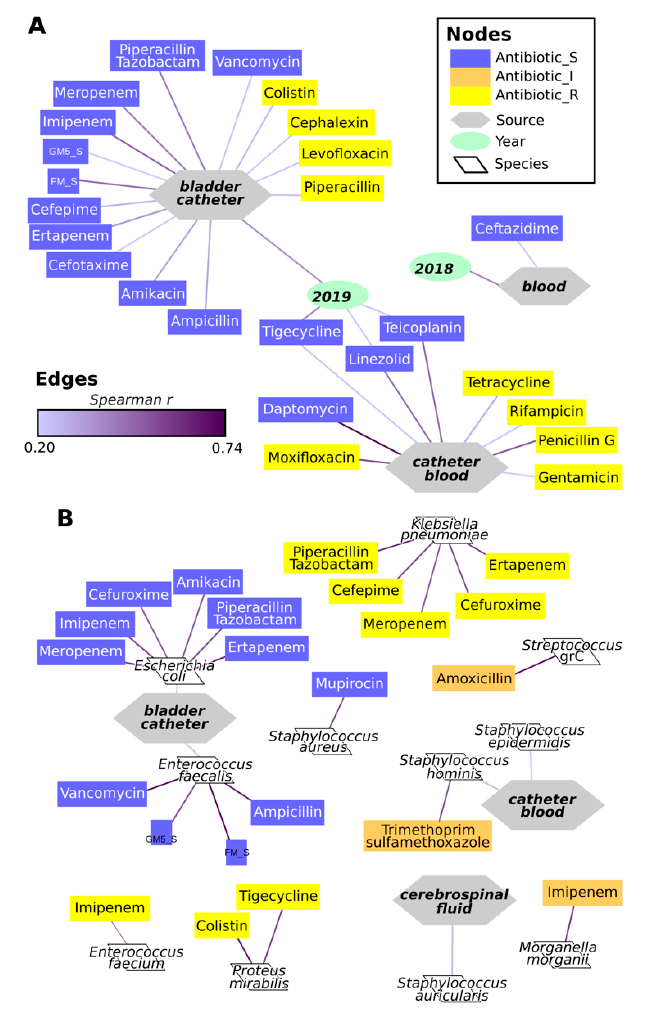
Figure 7. Spearman correlations among year, source of isolation, microbial species, and susceptibility to antibiotics. ( A ) correlations among year and source of isolation and susceptibility to antibiotics. ( B ) correlations among microbial species and sources and year of isolation and susceptibility to antibiotics. Edges indicate the presence of a significant correlation (Spearman correlation r > 0.2 and fdr < 0.05), with the color of the line indicating the correlation r, as indicated in the legend. To simplify the representation, only correlations with r > 0.5 are shown for relations between microbial species and other variables.